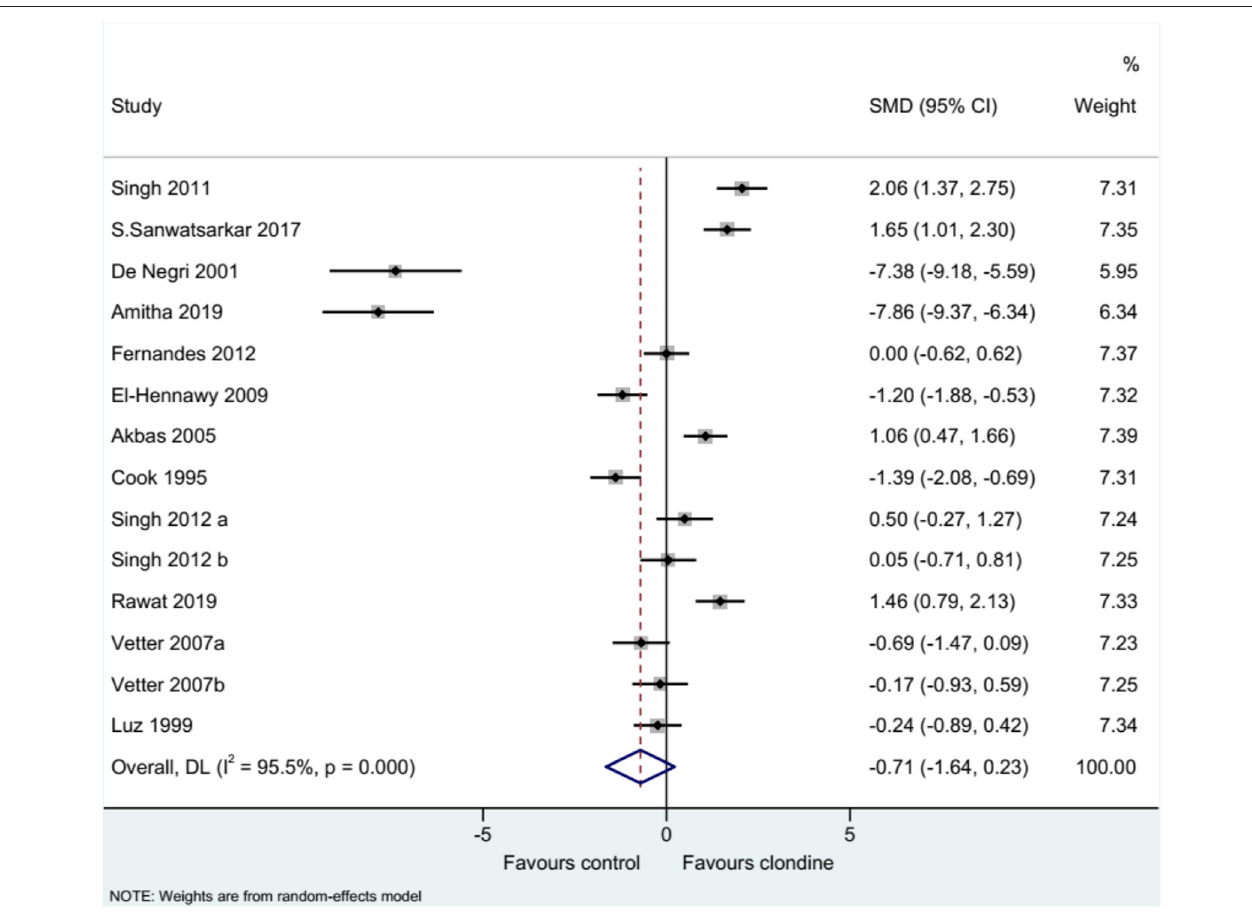
FIGURE 2 | Duration of analgesia